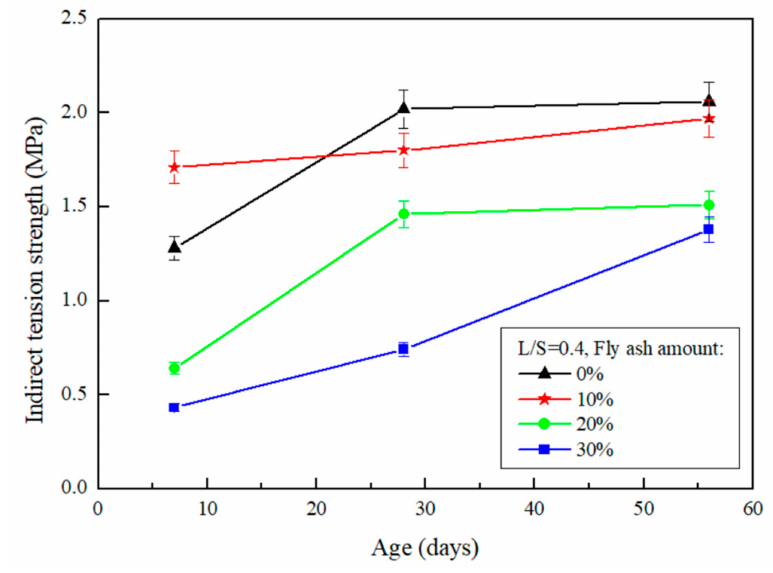
Figure 8. The e ff ect of di ff erent fly-ash amount on FGG split tensile test when L / S = 0.4.